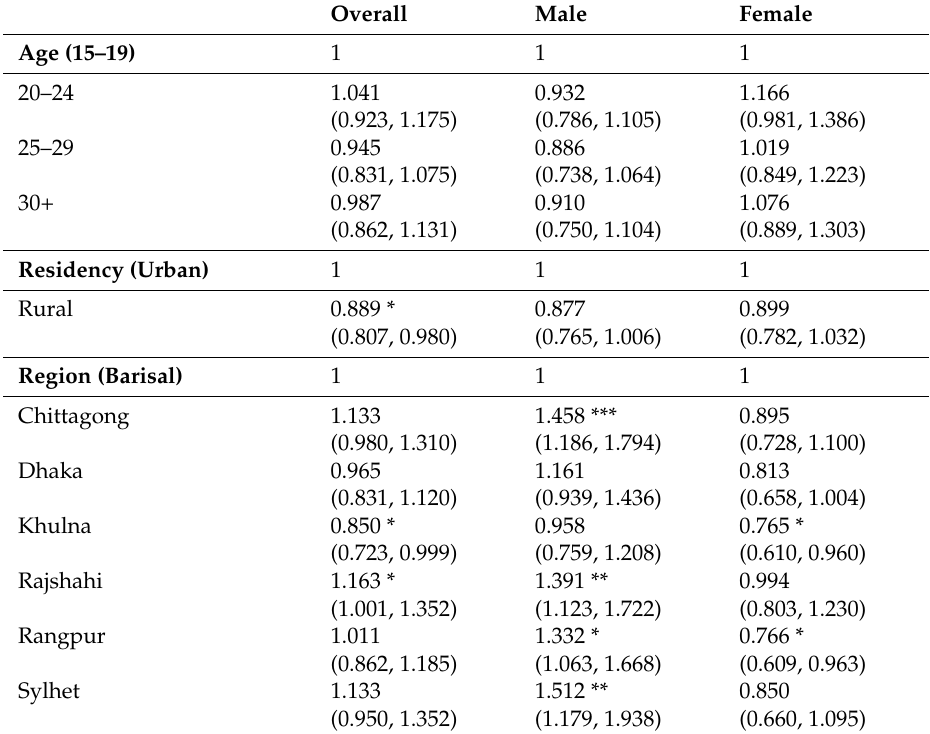
Table 1. Predictors of fever among under-five children in Bangladesh, Bangladesh Demographic and Health Survey